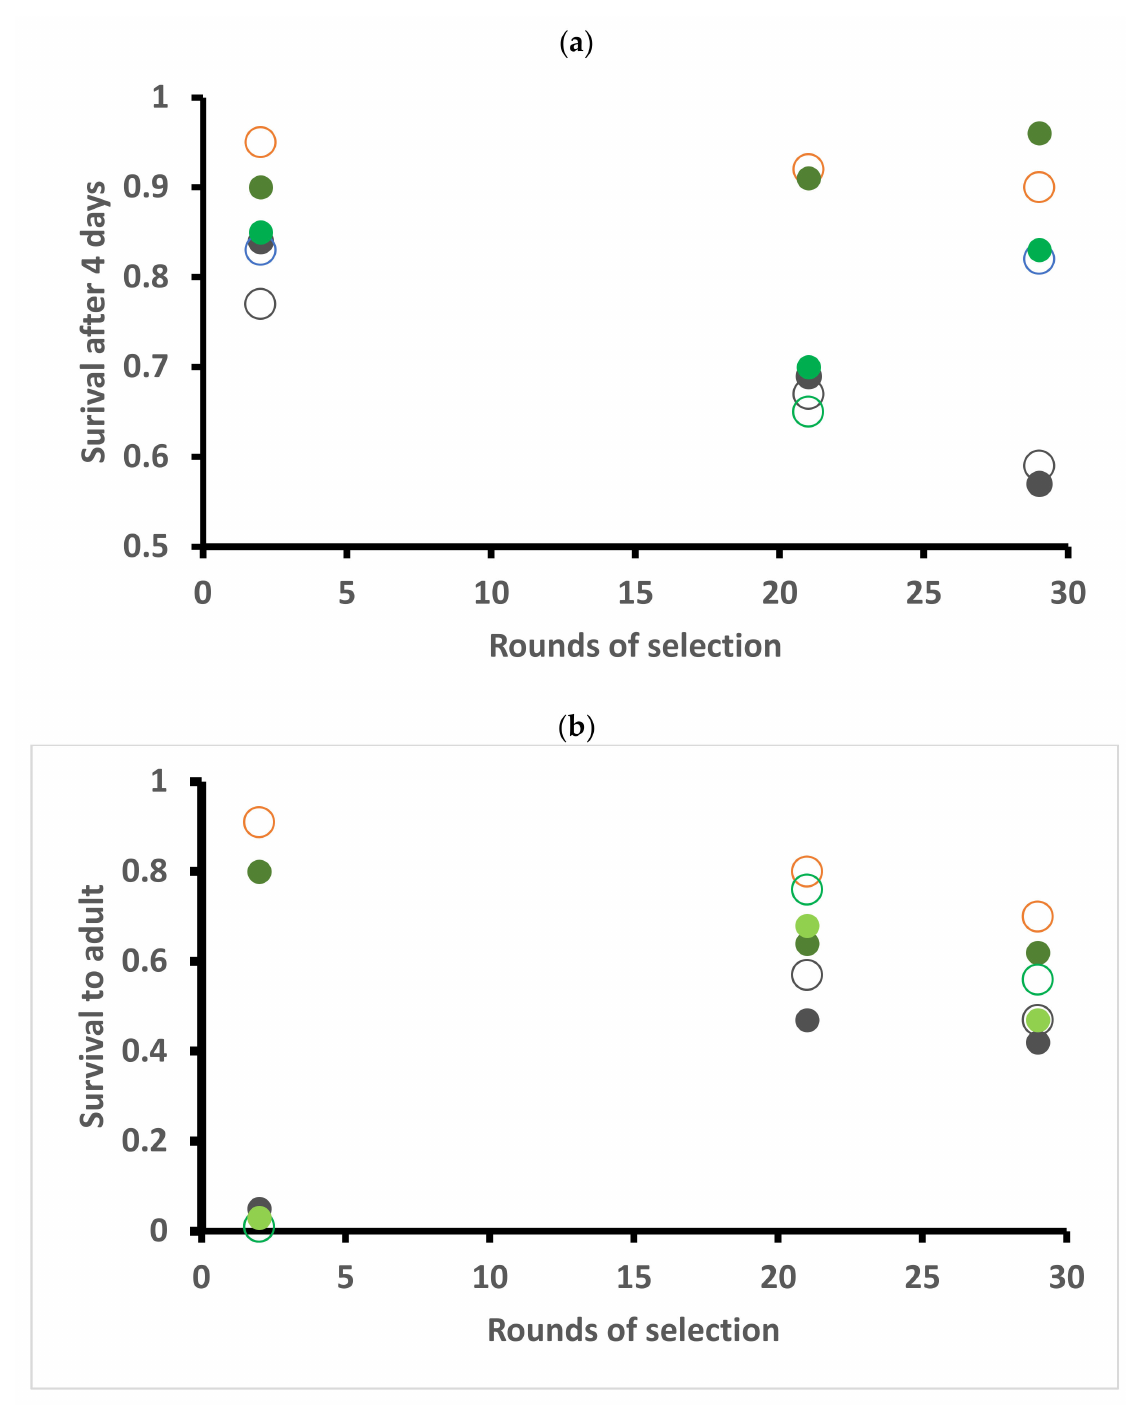
Figure 1. Percentage survival of early instars ( a ) and to the adult stage ( b ) of Helicoverpa armigera Toowoomba strain (large open circles) and Brassica-selected strain (solid smaller circles) when reared on artificial diet (brown), cabbage (dark green) or kale (light green), assessed at the indicated rounds of selection (Supplementary Table